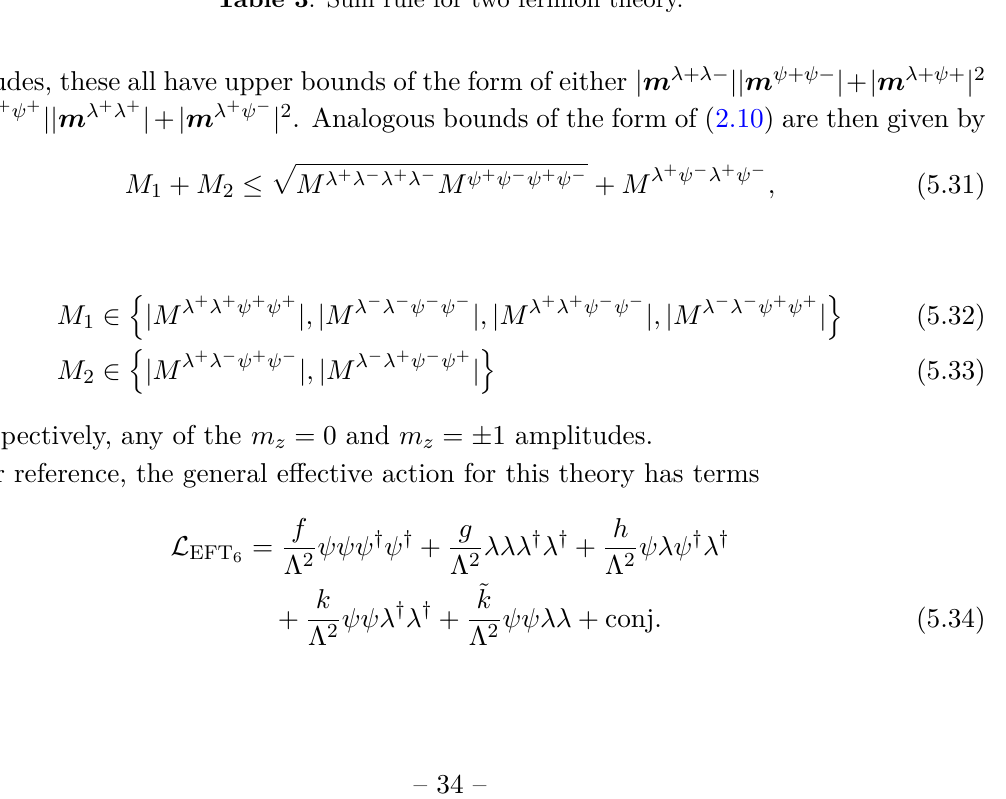
Table 3 . Sum rule for two fermion